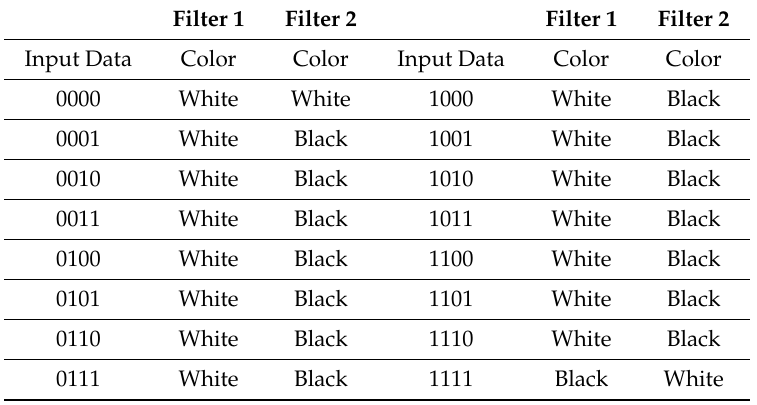
Table 2. Examples of noise filter (Filter 1) and object boundaries filter (Filter